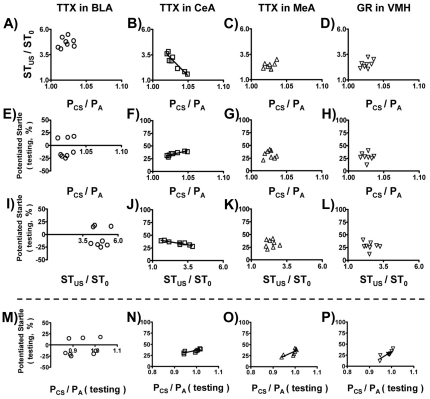
Pharmacological interventions to locally block one or both of the fear learning pathways and the consequences on the fear-potentiated startle.The blockers were locally injected into BLA, CeA, MeA or VMH to block local neuron activity before training session. Results were analyzed by Pearson's correlation analysis for individual group. Panels with line marks indicate significant correlation between the ordinate and the abscissa. Results from measuring PCS/PA values in the training session indicated that the MeA/VMH-mediated fear learning pathway, but not the CeA-mediated pathway, was BP-related (A–L). However, local blockages in CeA, MeA, or VMH all retained partial fear learning and memory (M–P).